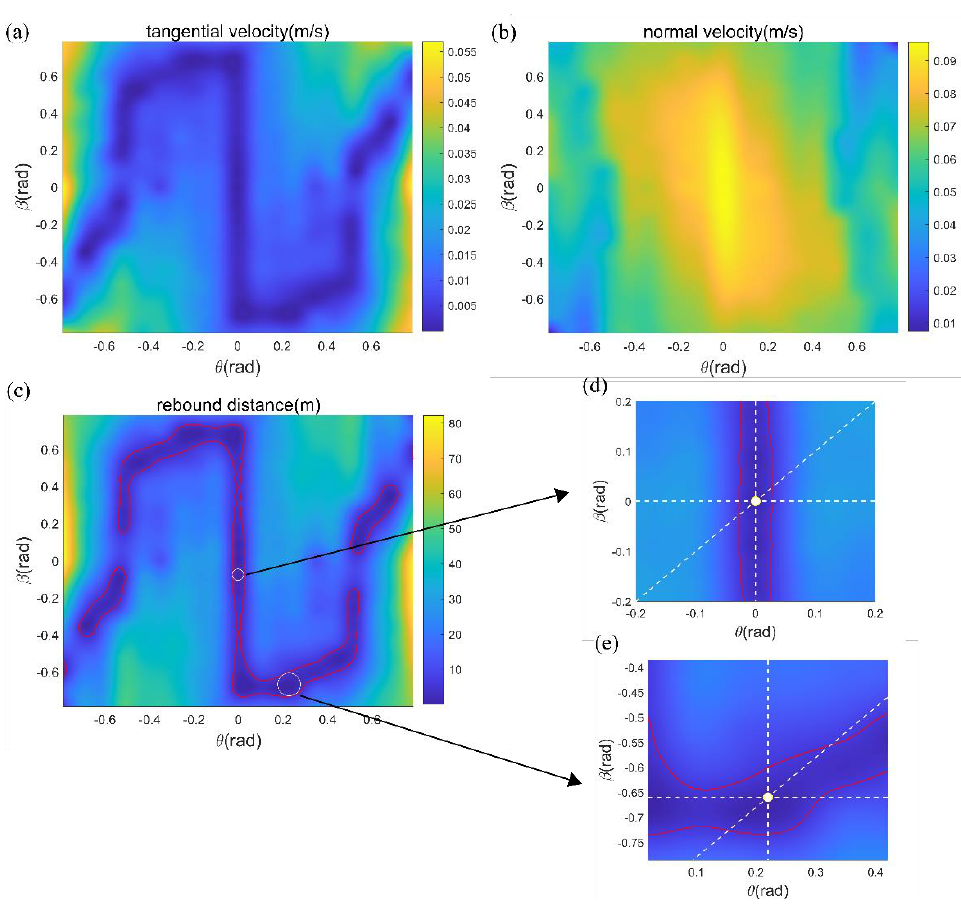
Figure 13. ( a ) The rigid lander’s tangential velocity after the first collision at v 0 = 0.1 m/s ; ( b ) the rigid lander’s normal velocity after the first collision at v 0 = 0.1 m/s; ( c ) the rigid lander’s rebound distance at v 0 = 0.1 m/s; ( d ) local amplification of the origin in ( c ); ( e ) local amplification of α = 0.22, β = − 0.66 in ( c